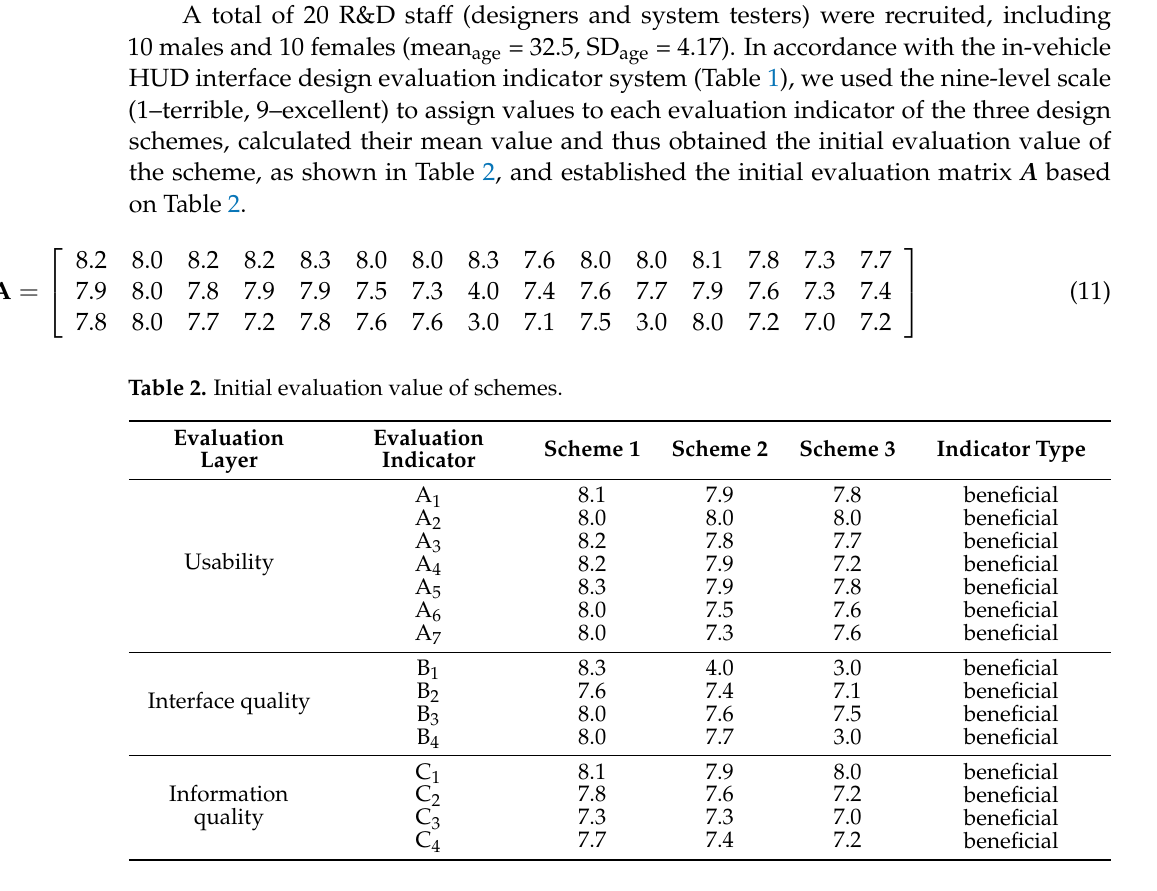
Figure 4. HUD interface design scheme 3. The plane navigation arrow is used in scheme 3. Although it seems to occupy a lot of visual space, the plane arrow fades to transparent at its back end, so it is actually like a solid arrow with a tail outlined. Semi-transparent triangle background and circular warning icons are used for FCWS.